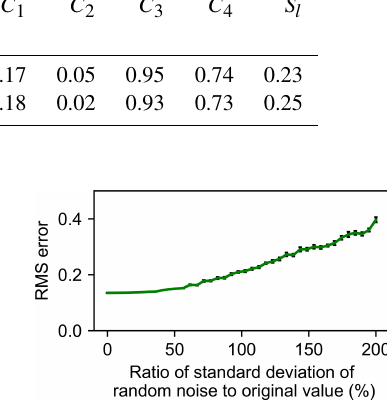
Figure 10. Result of inverse analysis of the test datasets with arti- ficial noise. The values of RMSE are averaged over 20 iterations. Error bars indicate standard errors of RMSE values.